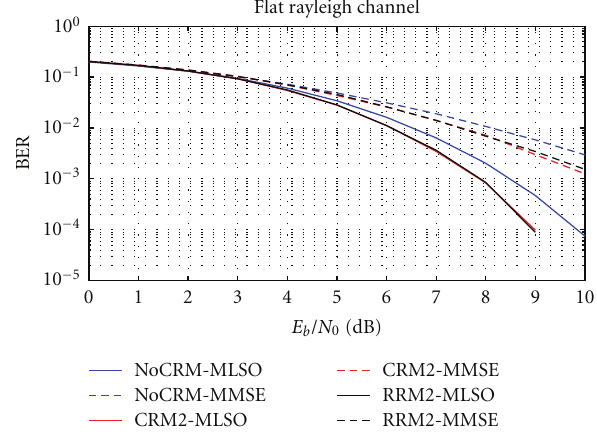
Figure 6: BER performance of a MIMO turbo-coded transmission with RM, Flat Rayleigh